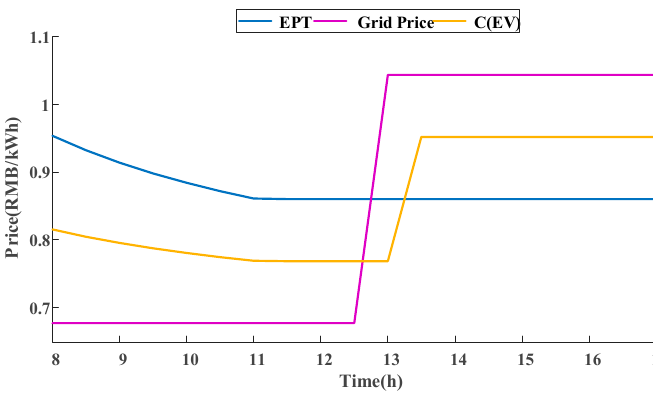
Figure 9. EPT and sell price of EV.